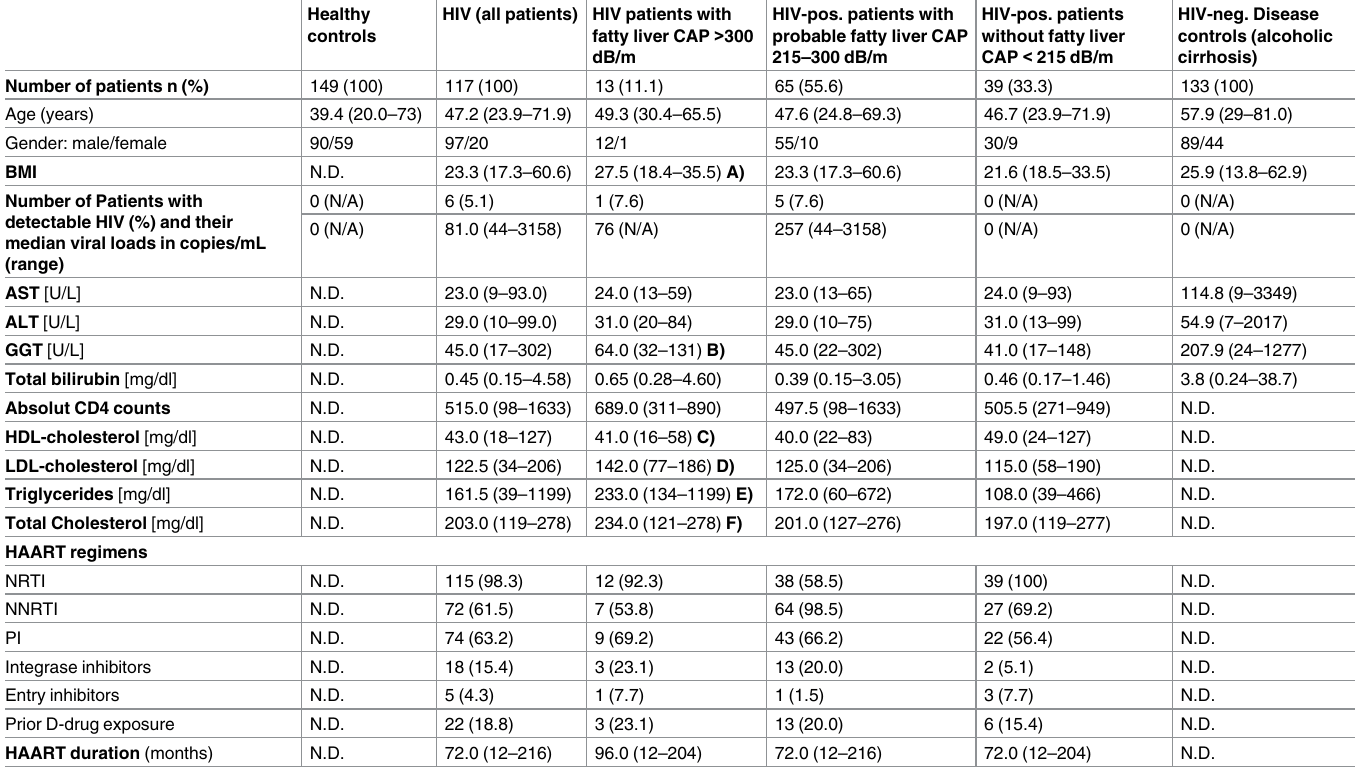
Table 1. Patient